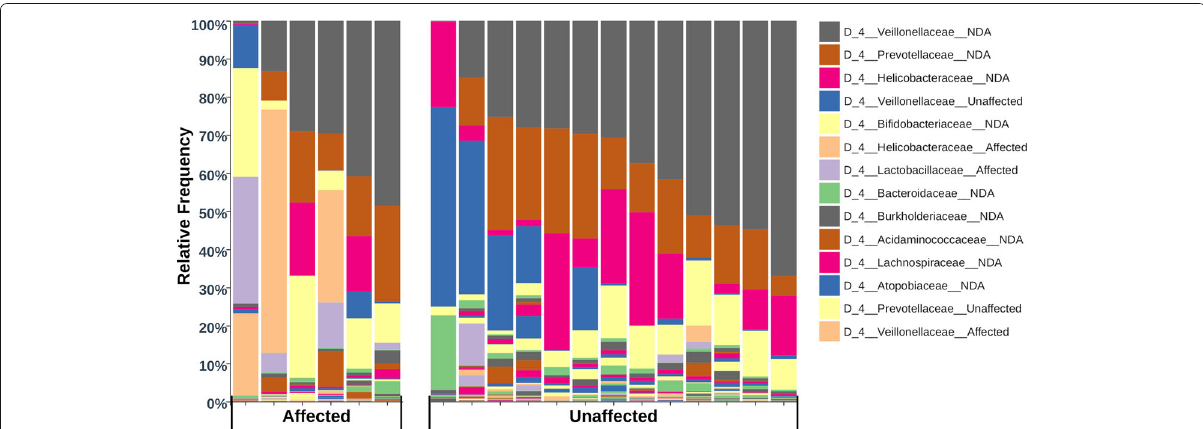
Fig. 5 The relative abundance of bacterial families in the tamarin microbiome. The taxaplot also indicates whether contributing ASVs were classified as differentially abundant in unaffected (Unaffected) or affected (Affected) tamarins or not differentially abundant (NDA). ASVs assigned to Lactobacillaceae and Helicobacteraceae had a higher relative abundance in affected tamarins